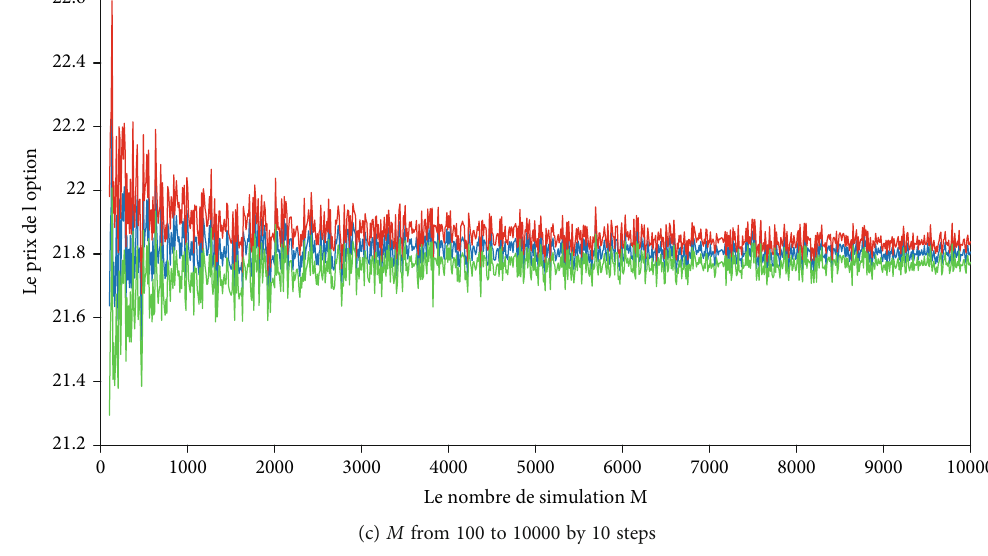
Figure 4: Numerical convergence of Monte Carlo simulation in the least square algorithm under the Lévy jump-di ff usion model. Con fi dence level in order of 95% (the estimated value of the American option in blue, upper bound in red, and lower bound in